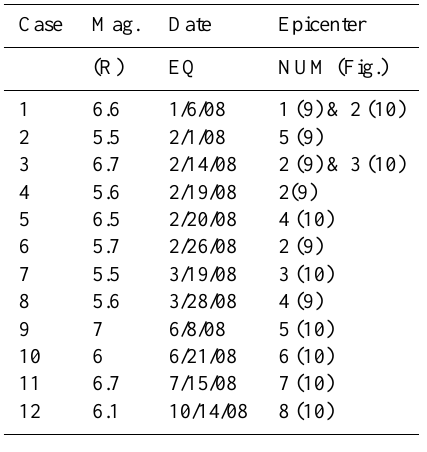
Fig.6. Example of STFT with adaptive sliding window